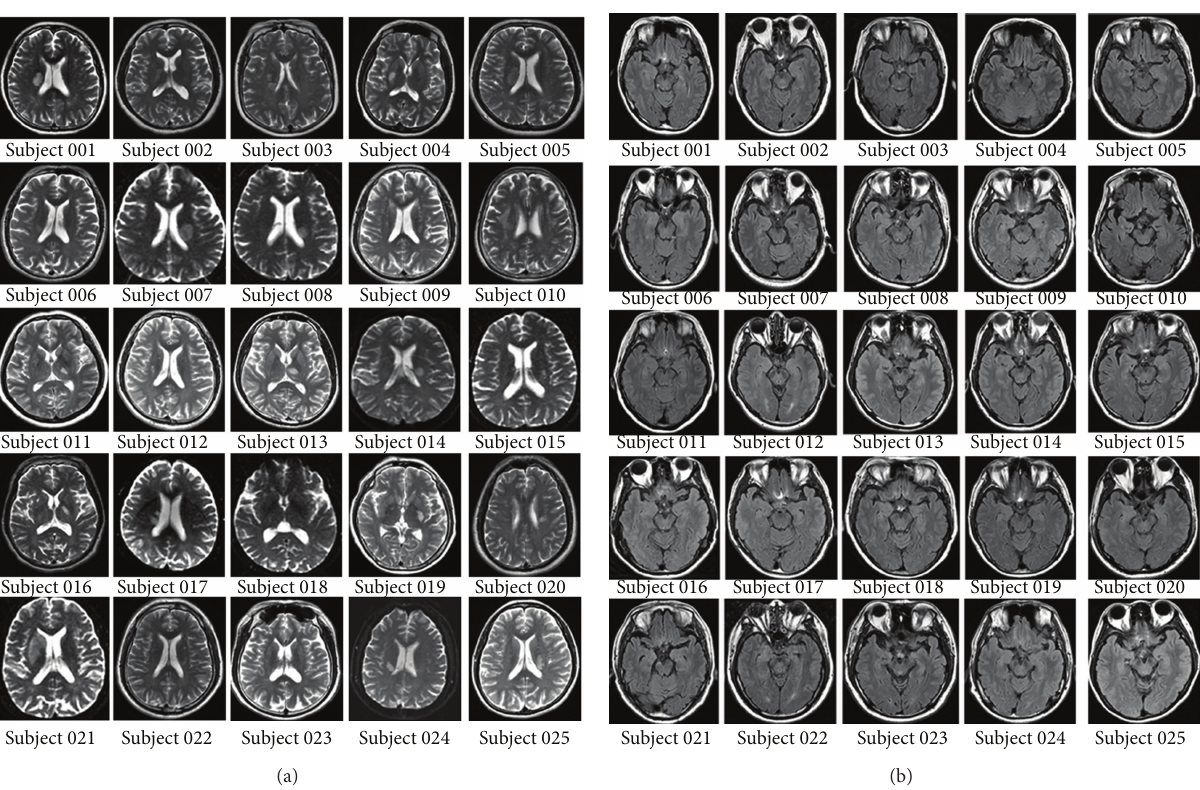
Figure 1: (a) Lesion locations of stroke patients on axial T2-weighted images acquired at the stroke onset when stroke patients were first enrolled in our hospital. (b) The morphology and signals of the brainstem of every stroke